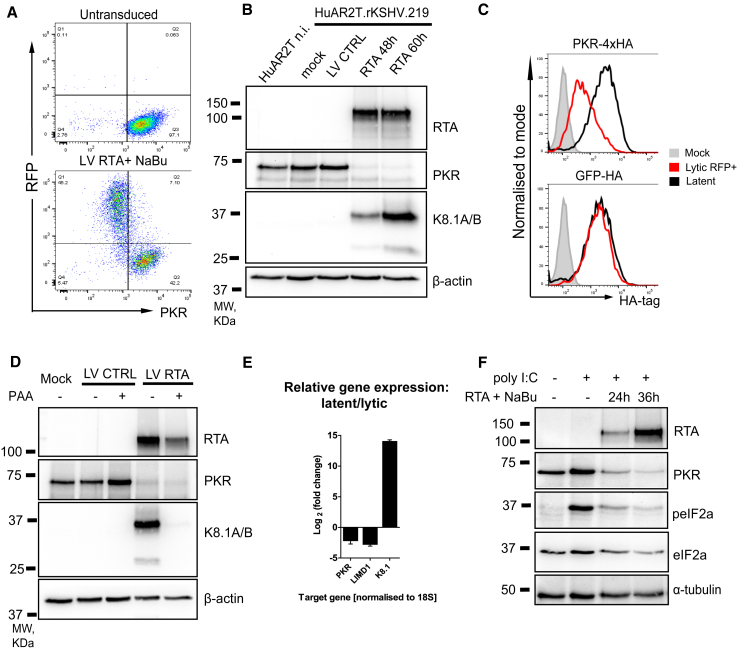
Protein Kinase R Is Downregulated by Lytic KSHV Infection(A) Flow cytometry analysis of HuAR2T.rKSHV.219 cells with latent (top panel) and lytic (bottom panel) KSHV infection.(B) Immunoblot analysis of uninfected HuAR2T cells (lane 1) and HuAR2T.rKSHV.219 cells (lanes 2–5) in latent and lytic stages of KSHV infection.(C) Flow cytometry analysis of HuAR2T.rKSHV.219 cells with stable expression of PKR-4xHA and GFP-HA untreated or treated with reactivation mix and stained with anti-HA tag antibody. The signal from the HA tag is compared between the RFP+ population (red line) and the latent cells (black line).(D) Immunoblot analysis of HuAR2T.rKSHV.219 cells transduced with LV RTA or control LV, sorted on RFP+, and probed with the indicated antibody.(E) qRT-PCR analysis of the host and viral gene expression in cells with the lytic versus latent stage of infection. Data are represented as mean ± SEM.(F) Immunoblot analysis of HuAR2T.rKSHV.219 Cas9 cells treated with RTA reactivation mix and poly(I:C) and probed with the indicated antibody.